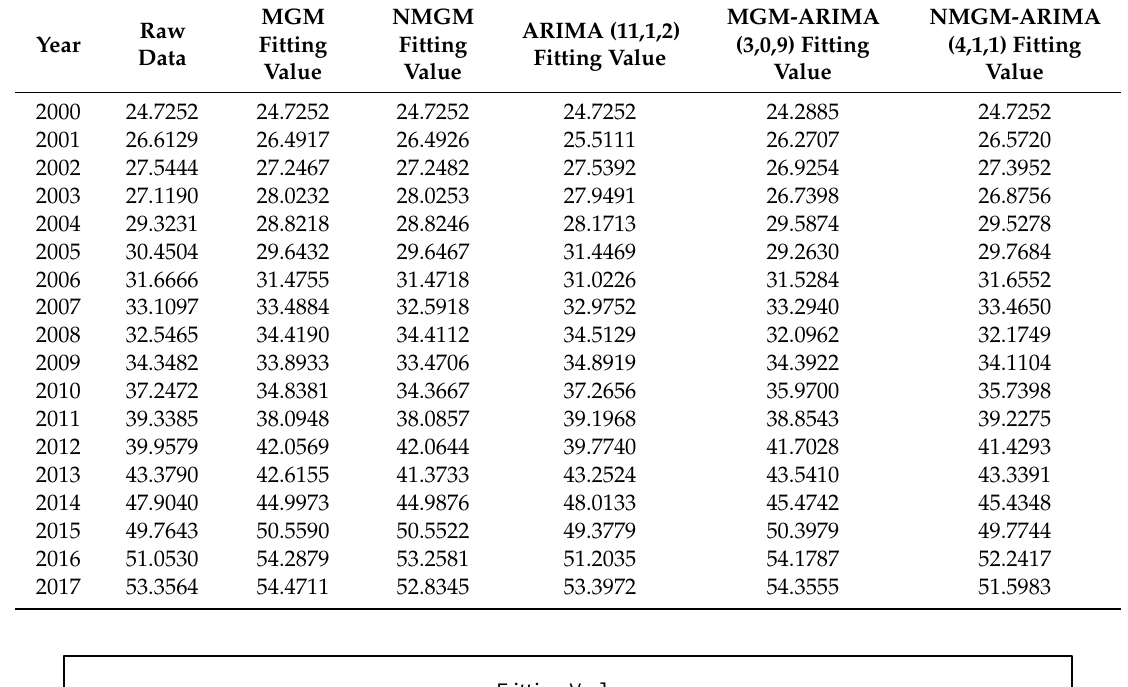
Table 13. Fitting results of five models (Unit:mtoe).